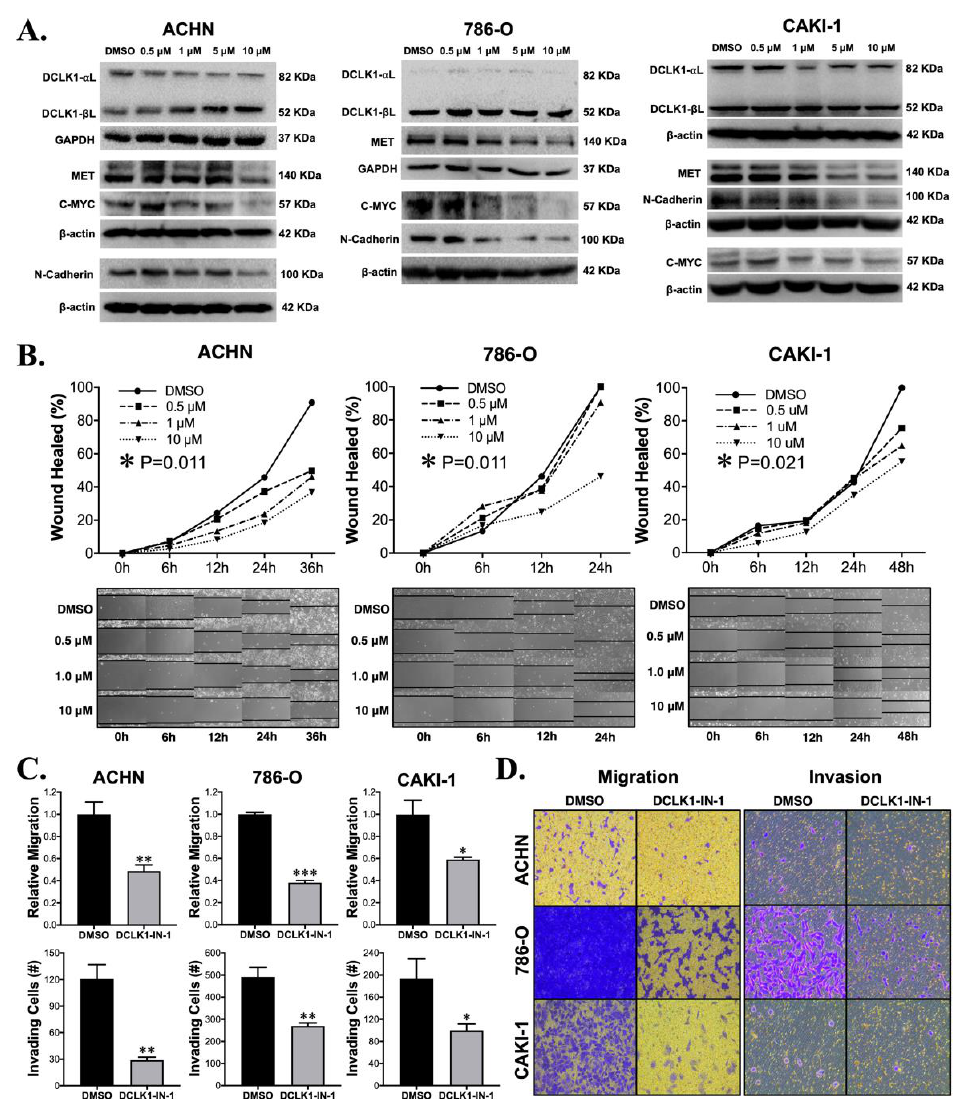
Figure 2. DCLK1-IN-1 treatment modulates DCLK1-associated pathway markers and inhibits